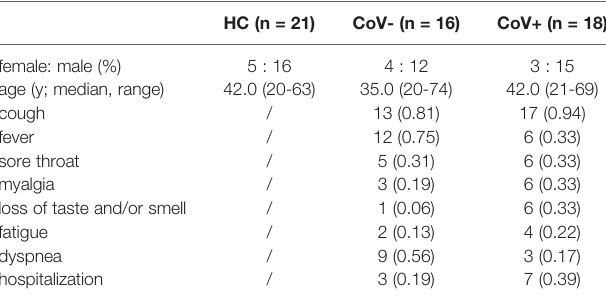
TABLE 1 | Patient characteristics of healthy control (HC) volunteers, symptomatic, COVID-19 negative tested patients (CoV-) and symptomatic, COVID-19 positive tested patients (CoV+).